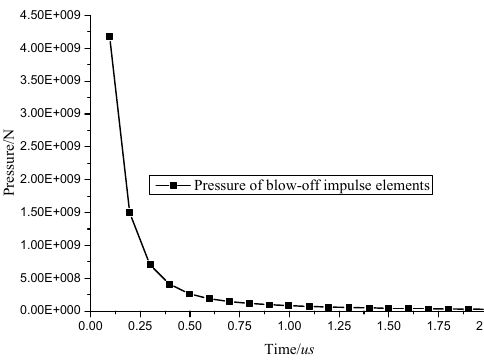
Figure 14. Pressure change of blow-off impulse elements.